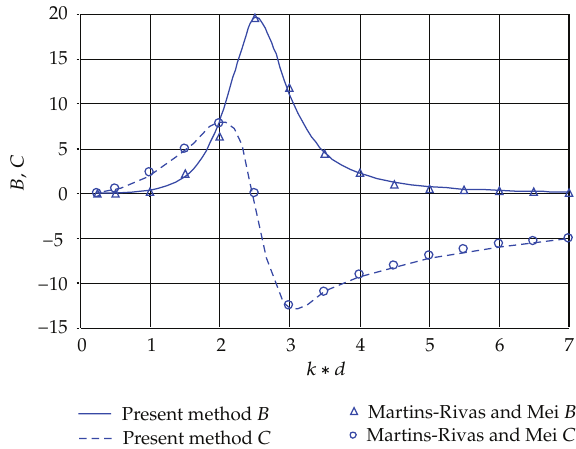
Figure 6: Conductance B and susceptance C for an isolated OWC device in the open